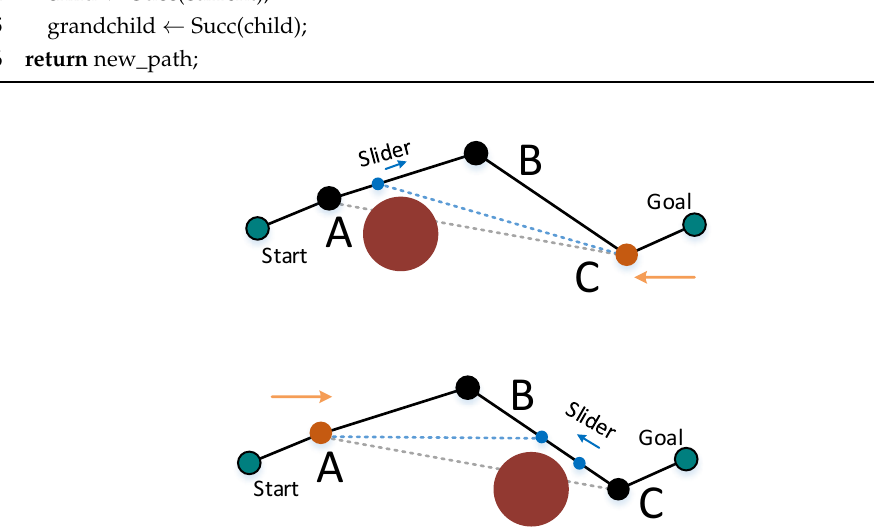
Figure 4. Backward-LoSS (top) and forward-LoSS (bottom). The slider node recurrently slides from the grandchild of the current node to the child of the current node by a small stepsize. In backward-LoSS, the current node moves from the goal node to the start node. In forward-LoSS, the current node moves from the start node to the goal